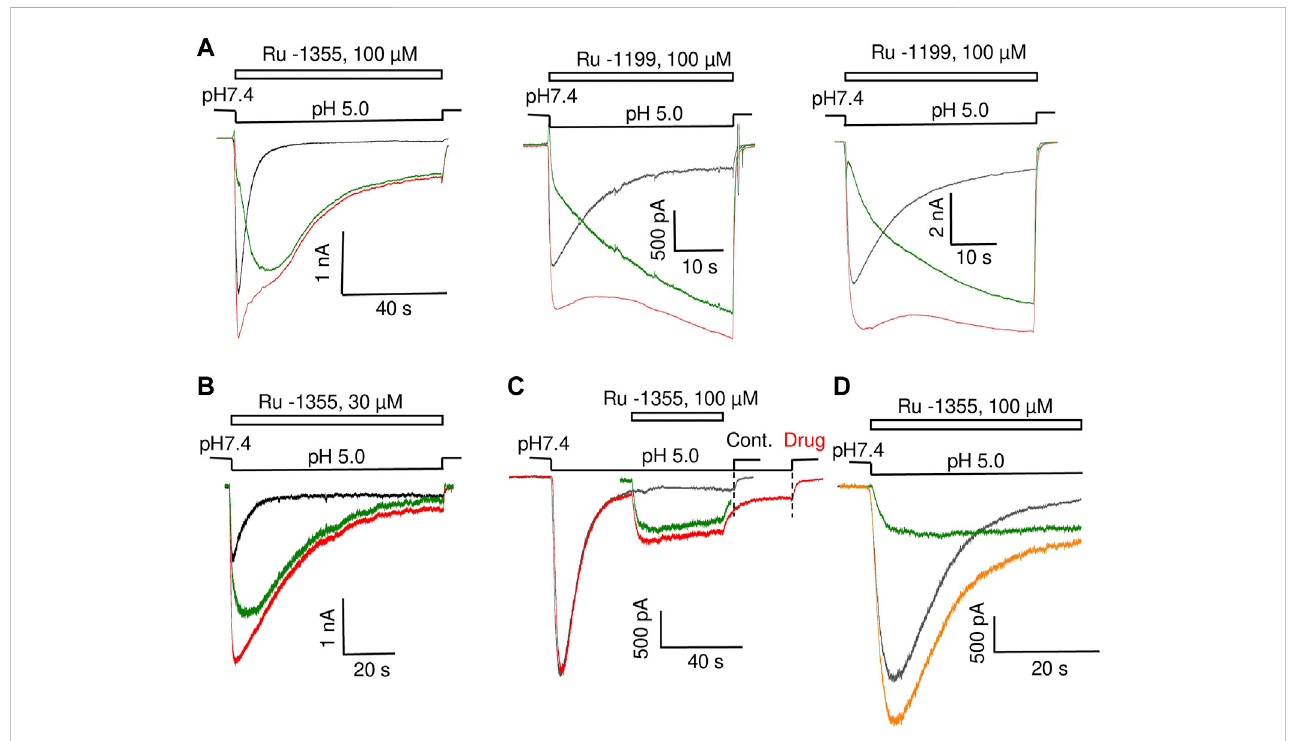
FIGURE 8 Additional ASIC2a currents evoked by Ru-1355 and Ru-1199. (A) , atypical ASIC2a responses in the presence of Ru-1355 or Ru-1199 (red) vs. the control response (black). Subtraction of the responses is shown in green. The result looks like an additional response, with slow kinetics of activation and desensitization. (B) , in the case of responses with mono-exponential decay, the result of subtraction is also seen as extra responses with slow kinetics. (C) ,applicationof 100 μ MRu-1355 after response equilibration causes an extra response with slow kinetics (green). (D) ,theextra response shown inC is computationally added at the beginning of the control response. The result of summation (orange) resembles the response in the presence of